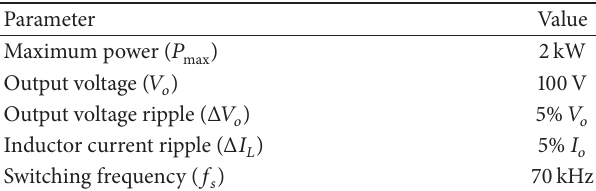
Table 2: Design specifications of the buck-boost converter.